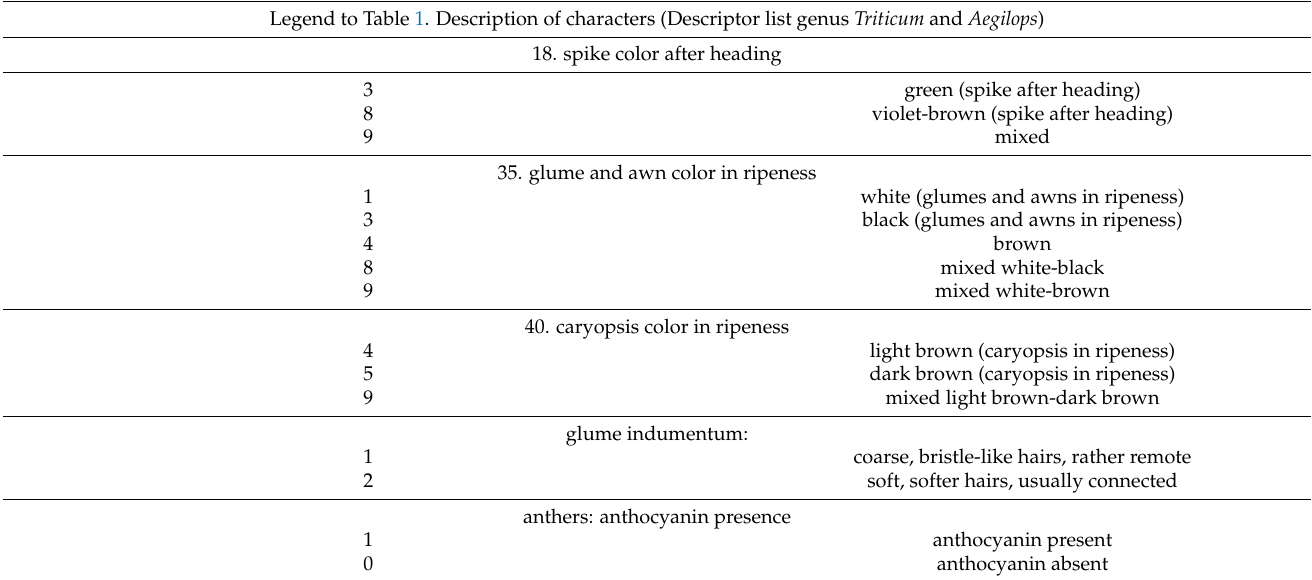
Legend to Table 1. Description of characters (Descriptor list genus Triticum and Aegilops ) 18. spike color after